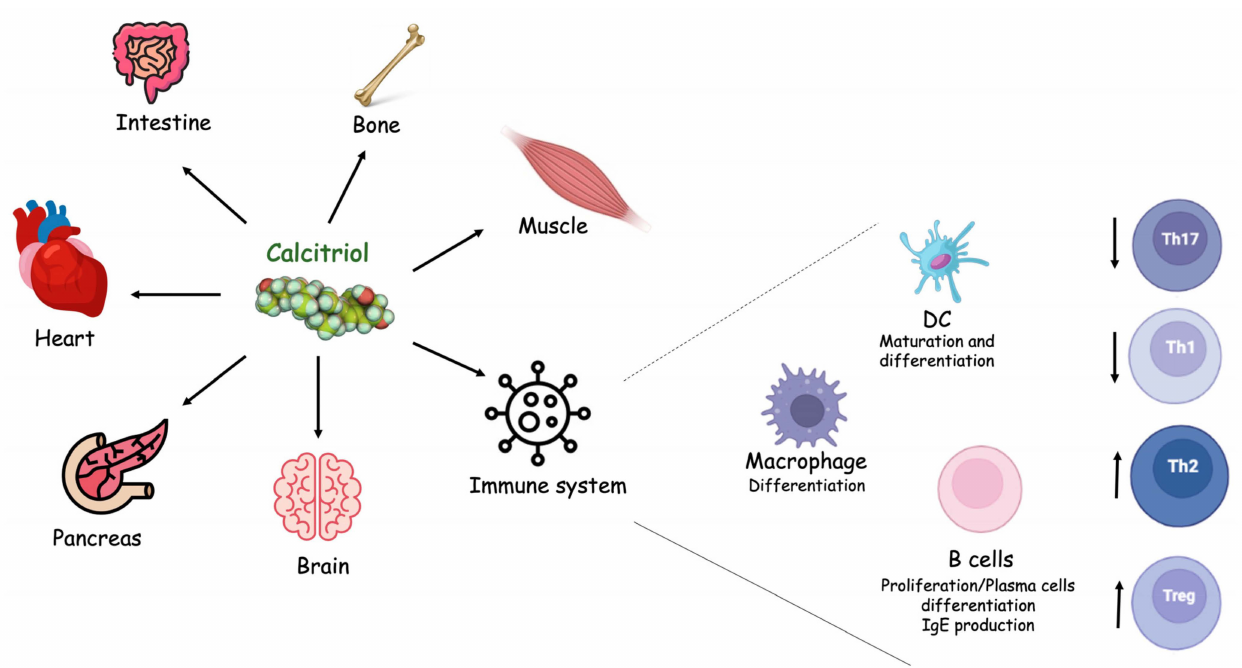
Figure 2. Vitamin D biological functions. Vitamin D’s active form, also known as calcitriol, exerts pleiotropic functions on different cells and